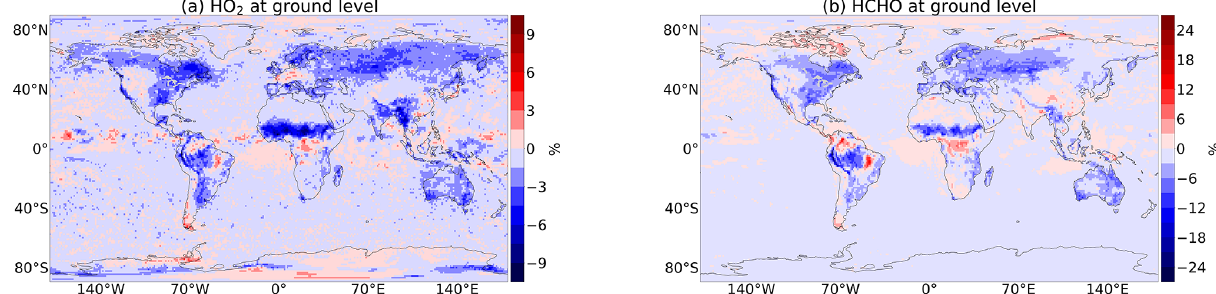
Figure 12. Relative change of multiyear (2010–2015) boreal summer mean (DEF –